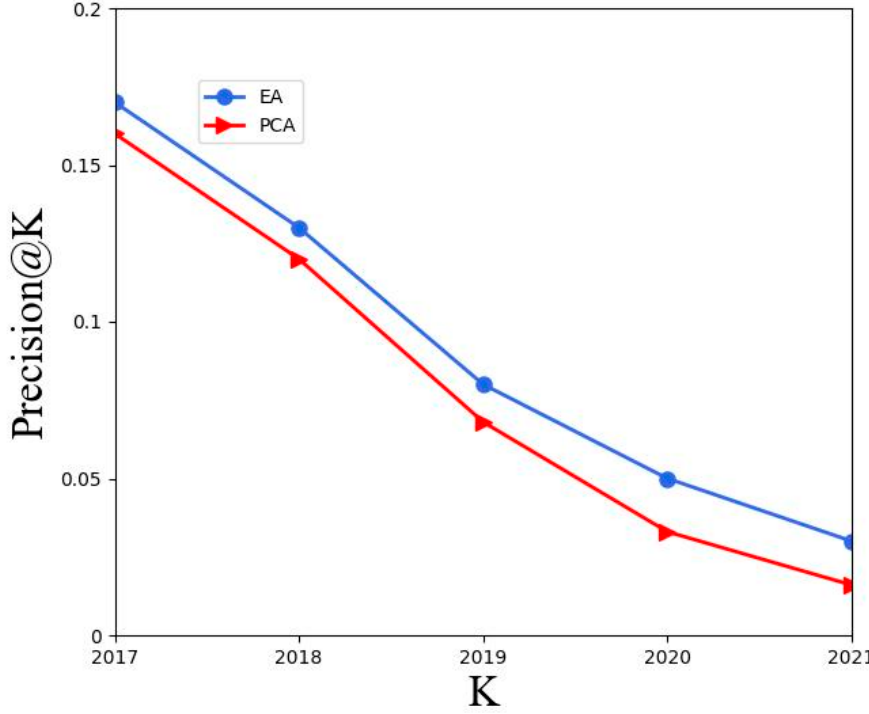
Figure 4. Experimental results of Precision@K on analysis popularity of tourism product